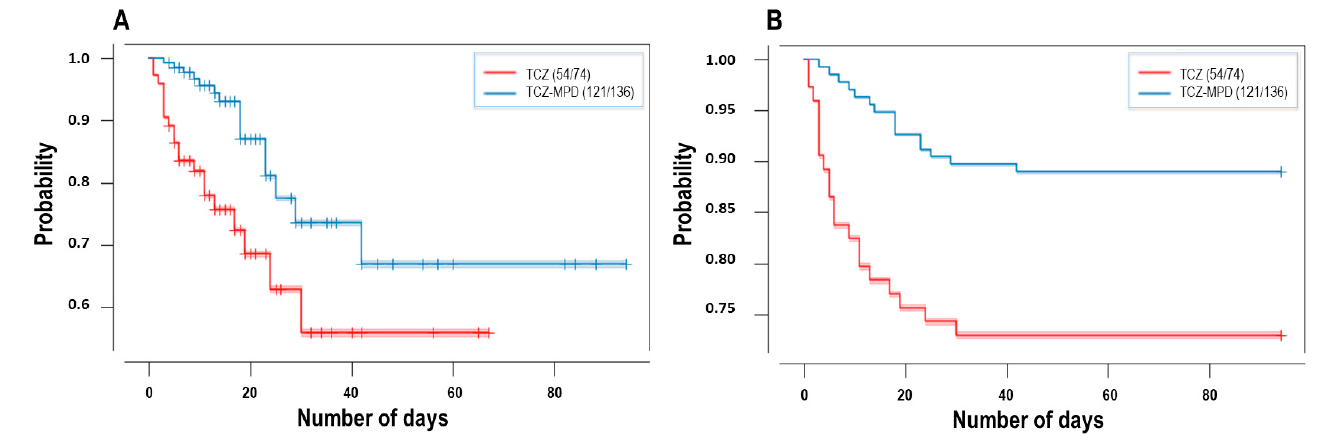
Figure 3. ( A ) Kaplan–Meier survival curves of mortality in admitted patients with severe COVID-19 censoring patients on the date of their discharge ( p = 0.00195, log-rank test). ( B ) Kaplan–Meier survival curves of mortality in admitted patients with severe COVID-19, without censoring patients ( p = 0.00151, log-rank test).